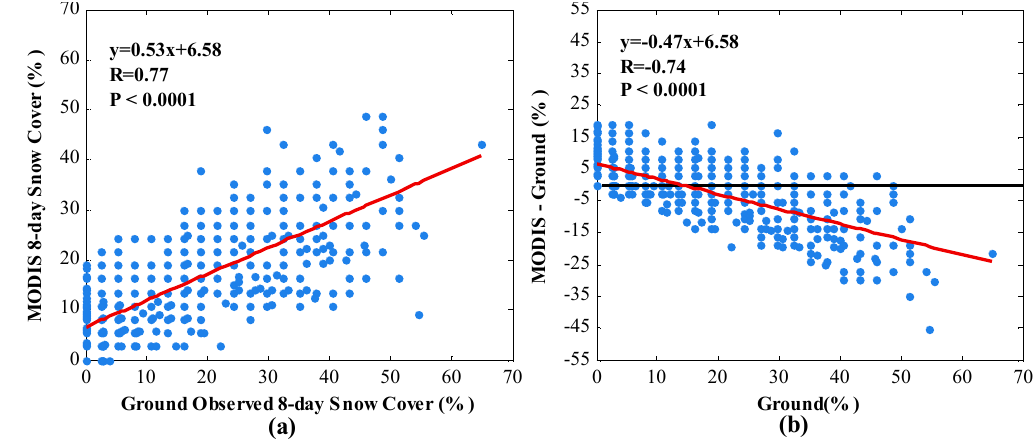
Figure 11. ( a ) The relationship between MODIS and ground observed snow cover at the stations. ( b ) Difference between MODIS and ground observed snow cover as a function of ground snow cover. The red lines are the respective linear regressions.